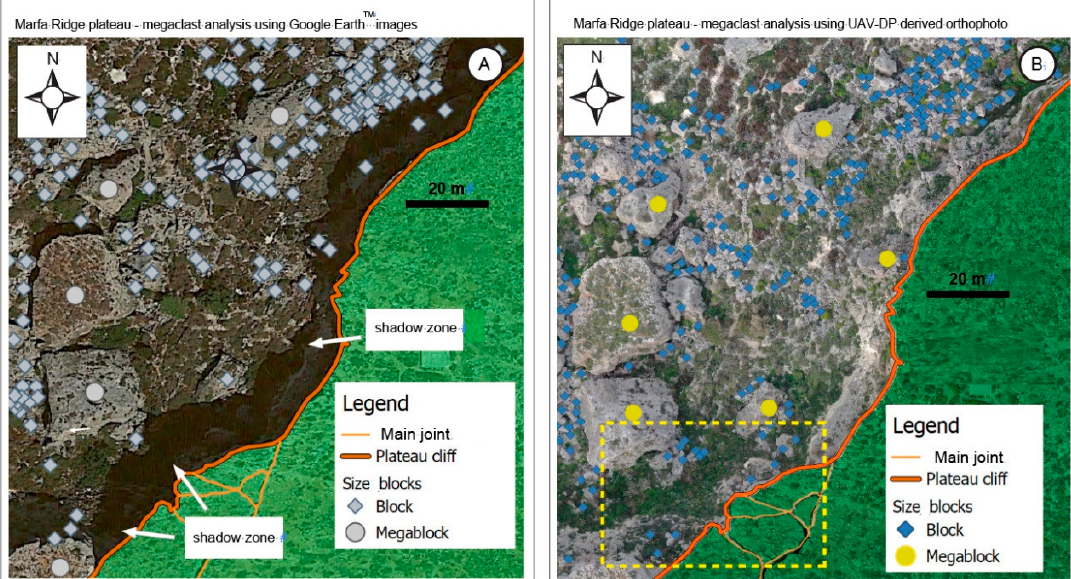
Figure 17. Identification and size categorization of Marfa Ridge megaclast deposit using ( A ) GE image where a 14 m wide shadow area complicates the recognition of megaclasts at the foot of the vertical escarpment that bounds the plateau; and ( B ) UAV-DP derived orthomosaic. The absence of an extensive shadow assists the GIS operator to identify in the area outlined by the dashed rectangle a dozen of blocks not recognized using GE